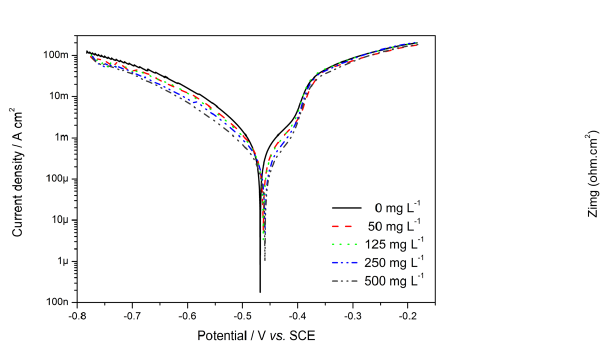
Figure 4: Nyquist plots obtained at the OCP for C‑steel in 1.0 mol·L -1 H SO with 2 4 with and without of methanolic Bauhinia purpurea e xtract at the following concentrations: 50, 125, 250 and 500 mg·L -1 at